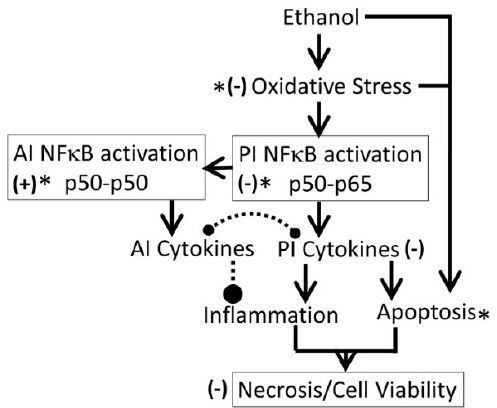
Figure 18. Proposed mechanism for ethanol-induced cytotoxicity. *: proposed target sites for AuNP’s protective effects. Solid lines: activation, broken lines: inhibition, ( − ): inhibitory effects of AuNPs and (+): activation by AuNPs. AI: anti-inflammatory, PI: pro-inflammatory.